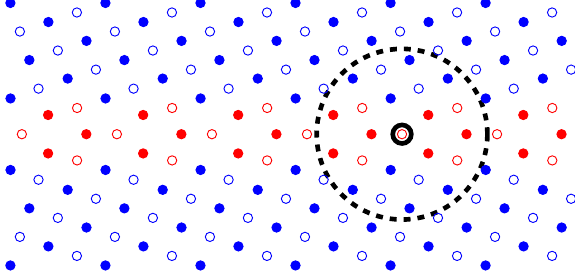
Fig. 6 Illustration of the most important LAE for classifying thermally damped GB mobility, as identi fi ed in a Σ 5 (36.9° symmetric (cid:4) tilt about the [100] axis, 013